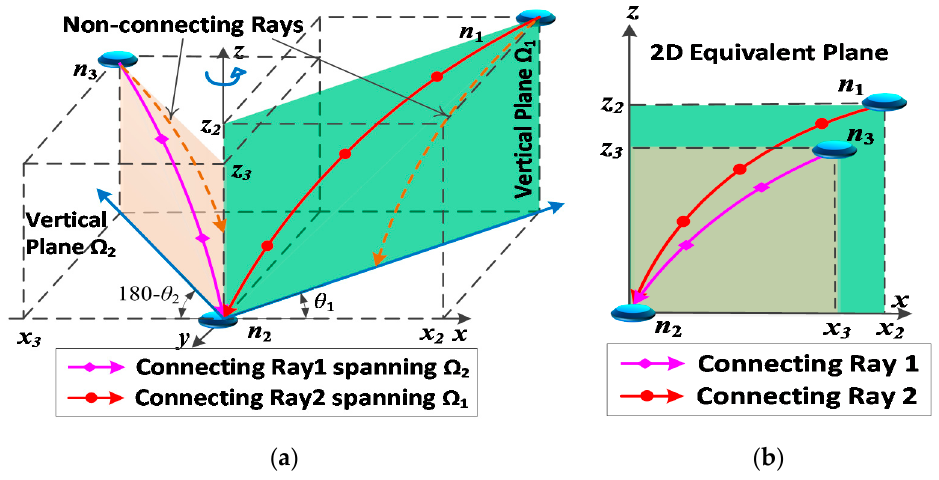
Figure 8. Conceptual representation of connecting rays where two distinct vertical subspaces are shown with their respective connecting-rays. To map the 3D environment ( a ) into 2D ( b ), we rotate each vertical plane along the z -axis until all the vertical planes merger into a single plane referred to as the process of superimposing